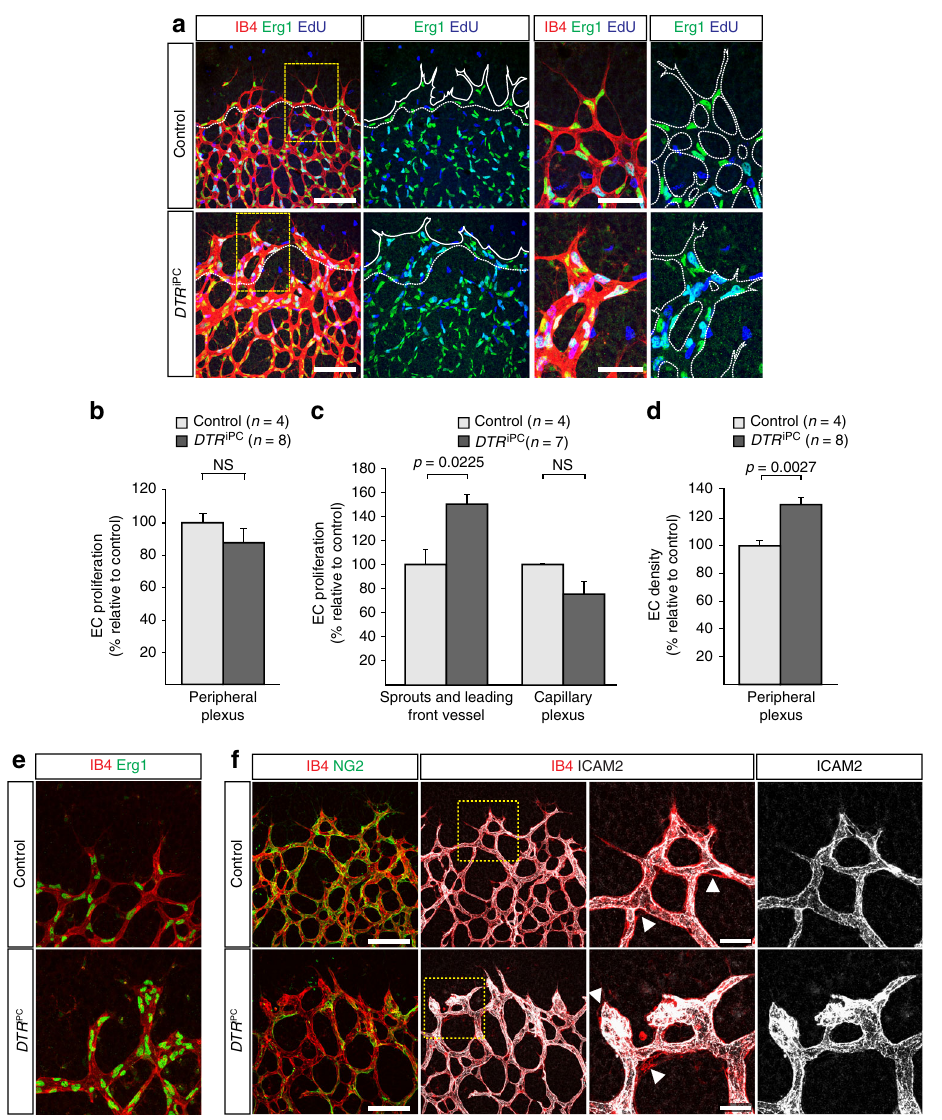
Fig. 3 Pericytes control endothelial behavior in angiogenesis. a Confocal images showing proliferating cells (EdU, blue), IB4 (red) and EC nuclei (Erg1, green) in the P6 control and DTR iPC retinal angiogenic front, as indicated. Images on the right show higher magni fi cation of boxed insets in left column. Dashed lines outline the angiogenic leading vessel from where the sprouts emerge (second column) or vessel shape (fourth column) at the edge of the vascular plexus. Scale bar, 100 µ m (left panels) and 50 µ m (higher magni fi cations). b – d Quantitation of total b and regional EC proliferation c as well as EC density d within the peripheral vascular plexus of P6 control and DTR iPC retinas. Error bars, s.e.m. p -values, Student ’ s t -test. NS, not statistically signi fi cant. e High magni fi cation of IB4 (red) and Erg1 (green) stained sprouts highlighting the accumulation of EC nuclei in P6 DTR iPC but not control sprouts. Scale bar, 50 µ m. f Confocal images showing IB4 (red), NG2+ pericytes (green) and vessel lumen (ICAM2, white) in the control and DTR iPC angiogenic front of P6 retinas. Images on the right show higher magni fi cation of boxed insets in the second column. Note that IB4 signal covers a larger area than the apical ICAM2 immunostaining (arrowheads in third column). Scale bar, 100 µ m (left panels) and 50 µ m (higher magni fi